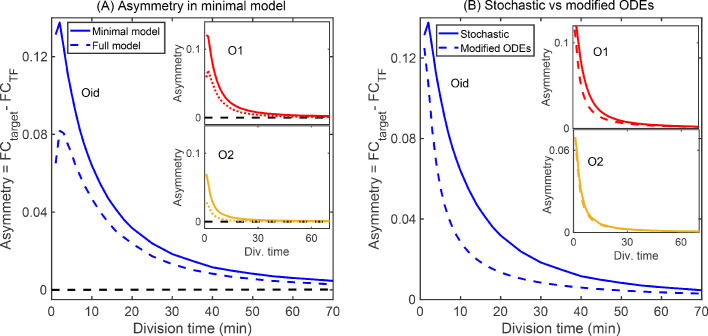
Minimal model of autoregulation.(A) Asymmetry predicted from a minimal model without intermediate transcription steps and decoy binding sites using stochastic simulations (solid lines in blue, red and yellow for Oid, O1 and O2 binding sites, respectively). The asymmetry follows similar trend as predicted in the complete stochastic model (shown as dashed lines). Stronger binding site (Oid, shown in solid blue line) shows higher asymmetry than a weak binding site (O2, shown in solid yellow line). Also, asymmetry decreases as the growth rate is increased. Black dashed line corresponds to the deterministic counterpart of the stochastic reaction systems. Again, we do not find any asymmetry in TF and target regulation from the deterministic solution. (B) Modified ODEs with the inclusion of four states each having a different TF concentration predict asymmetry (dashed lines for different binding sites; Oid [blue], O1 [red], and O2 [yellow]). However, the quantitative values disagrees from the stochastic simulations of minimal model shown as solid lines.